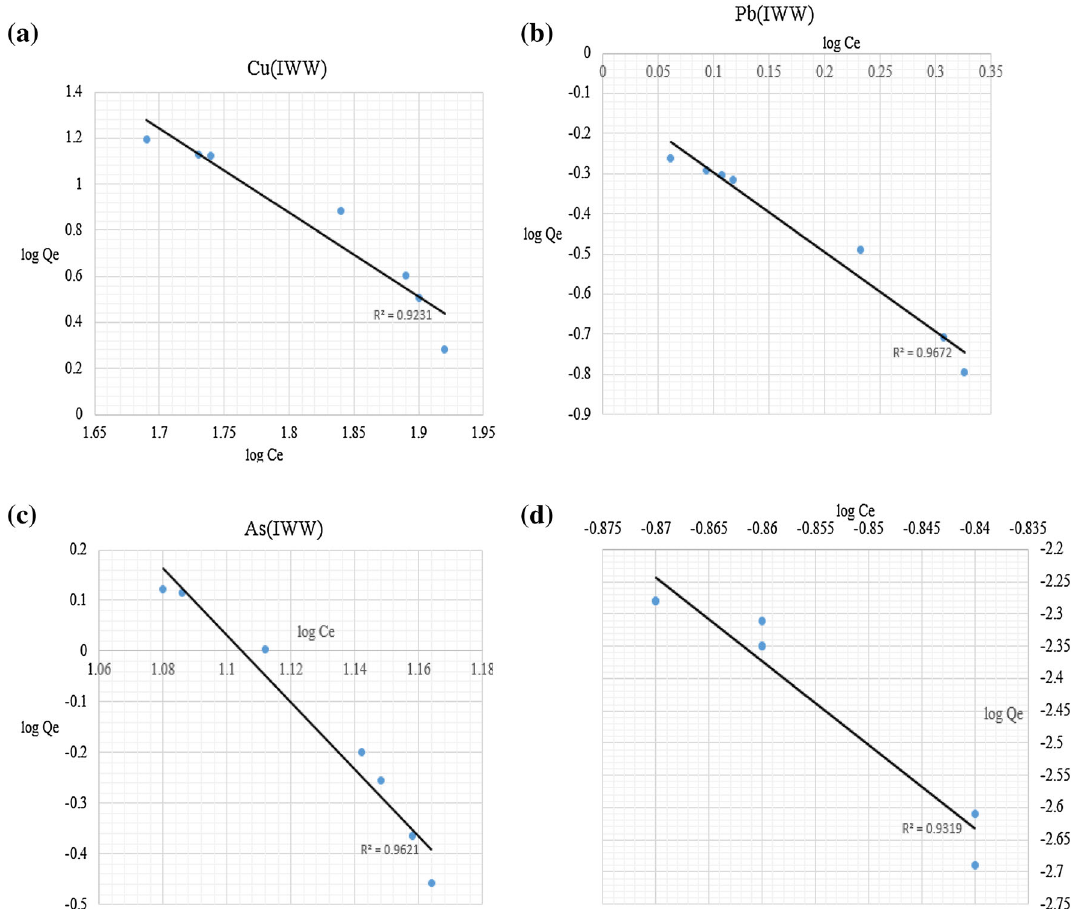
Fig. 10 Adsorption of heavy metals using Freundlich isotherm model in industrial wastewater at different proportions of B:C bioadsorbent. a Cu b Pb, c As, d